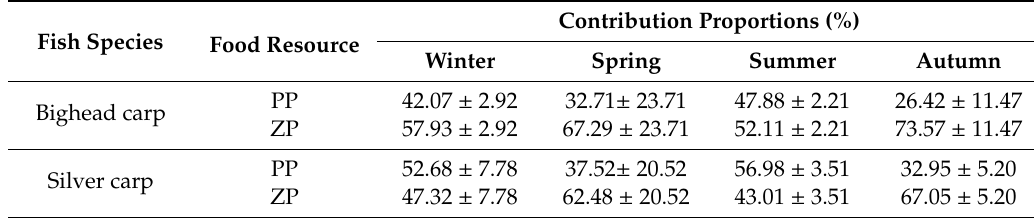
Table 2. Contribution proportions of food resources in phytoplankton (PP) and zooplankton (ZP) base on stable isotopic